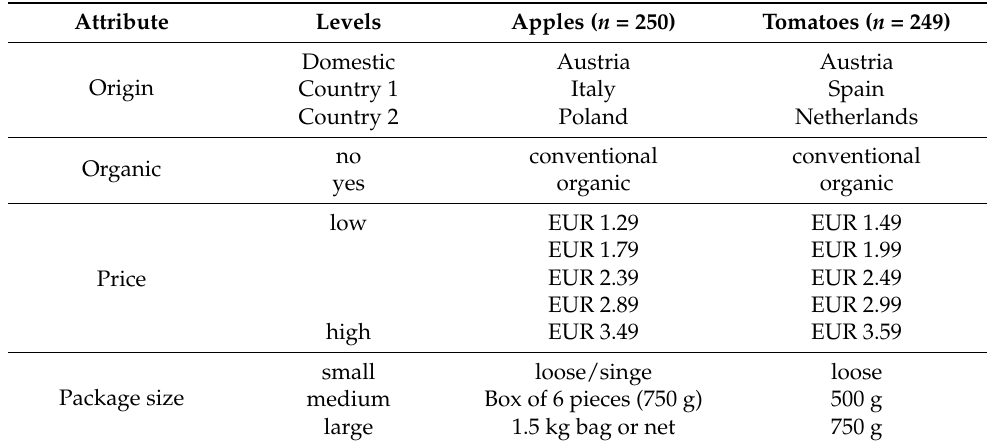
Table 1. Design of the choice